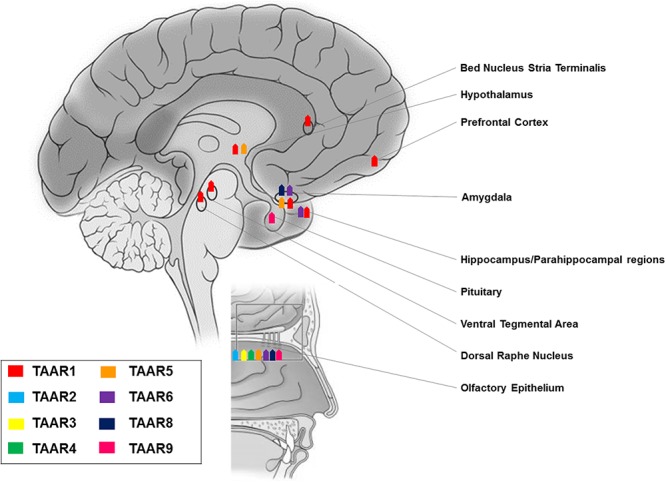
Anatomical distribution of TAARs: expression of members of the TAAR family in brain and olfactory mucosa.